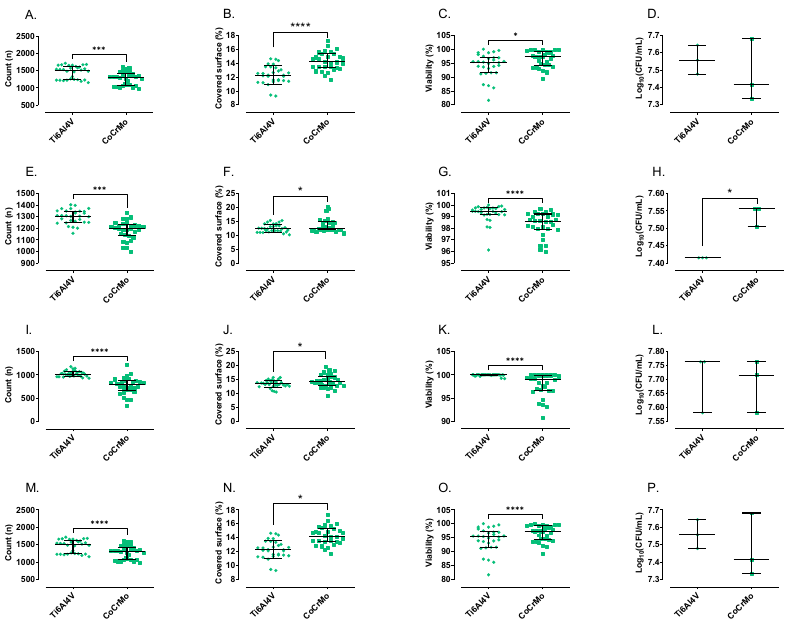
Figure 2. Counts ( A , E , I , M ), covered surface ( B , F , J , N ), adhered bacteria viability ( C , G , K , O ), and supernatant bacterial colony-forming units per millilitre ( D , H , L , P ) of S. aureus ( A – D ), S. epidermidis ( E – H ), E. coli ( I – L ), and P. aeruginosa ( M – P ). * p < 0.05; *** p < 0.001; **** p < 0.0001.